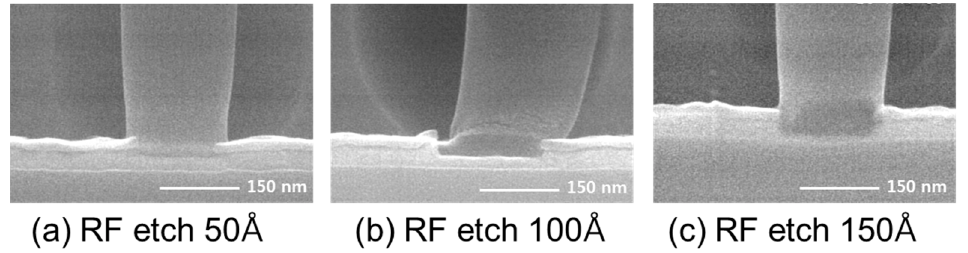
Figure 3. Cross-sectional SEM of etching amount of Co salicide according to Radio Frequency (RF) etch amount. ( a ) RF etch 50 Å. ( b ) RF etch 100 Å. ( c ) RF etch 150